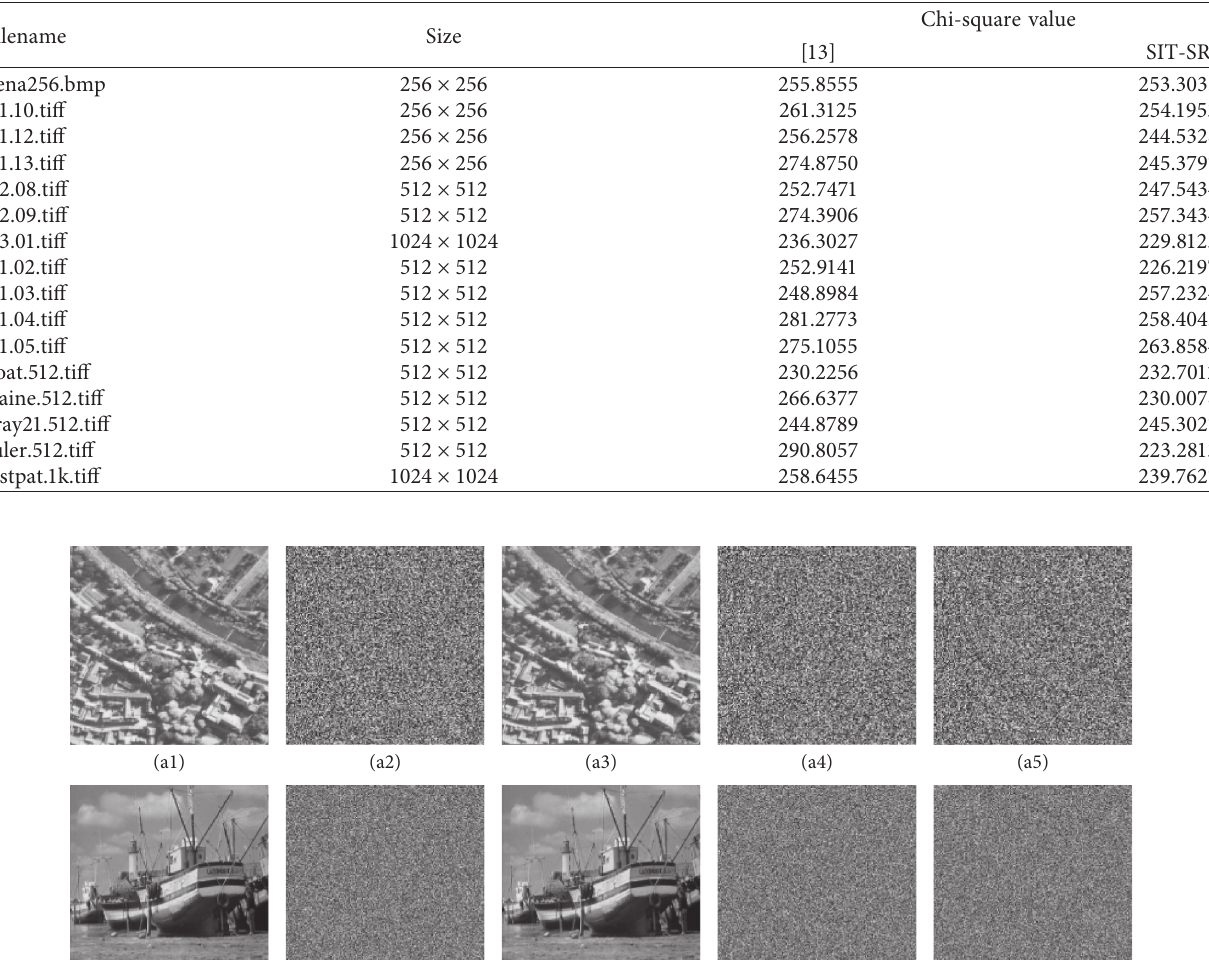
Table 6: Chi-square values of different cipher images.